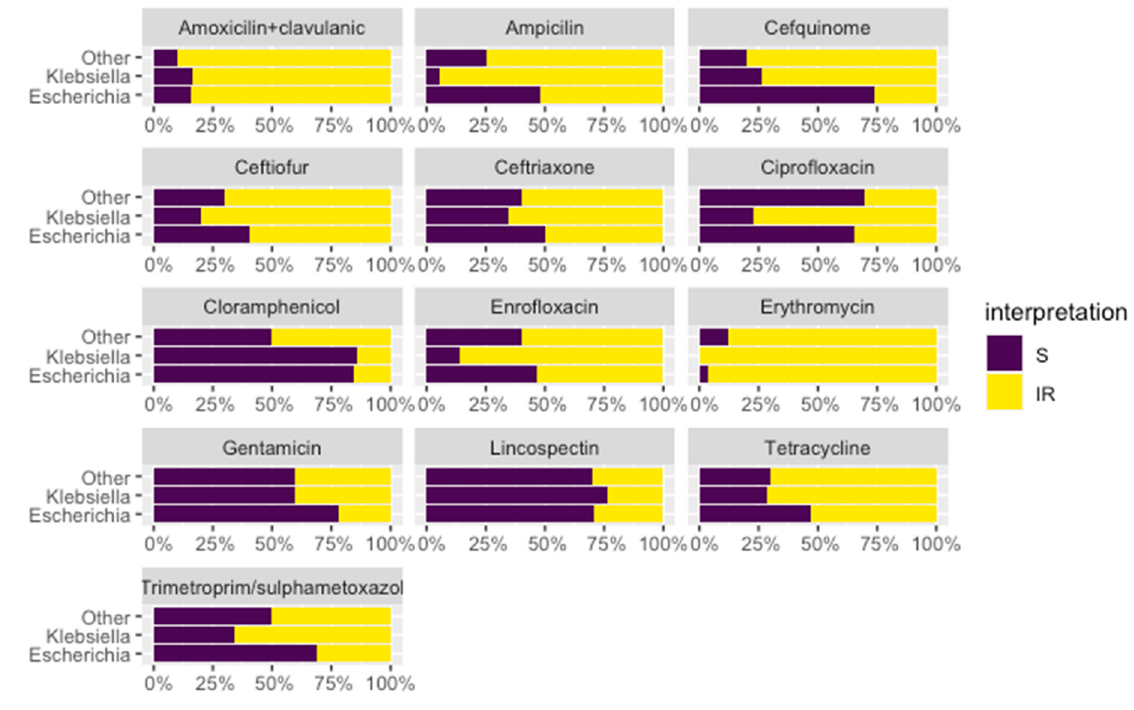
Figure 2. Antimicrobial susceptibility phenotype of the different isolates. Interpretation: S—sensitive (in purple); I—intermediate and R—resistant (in yellow).